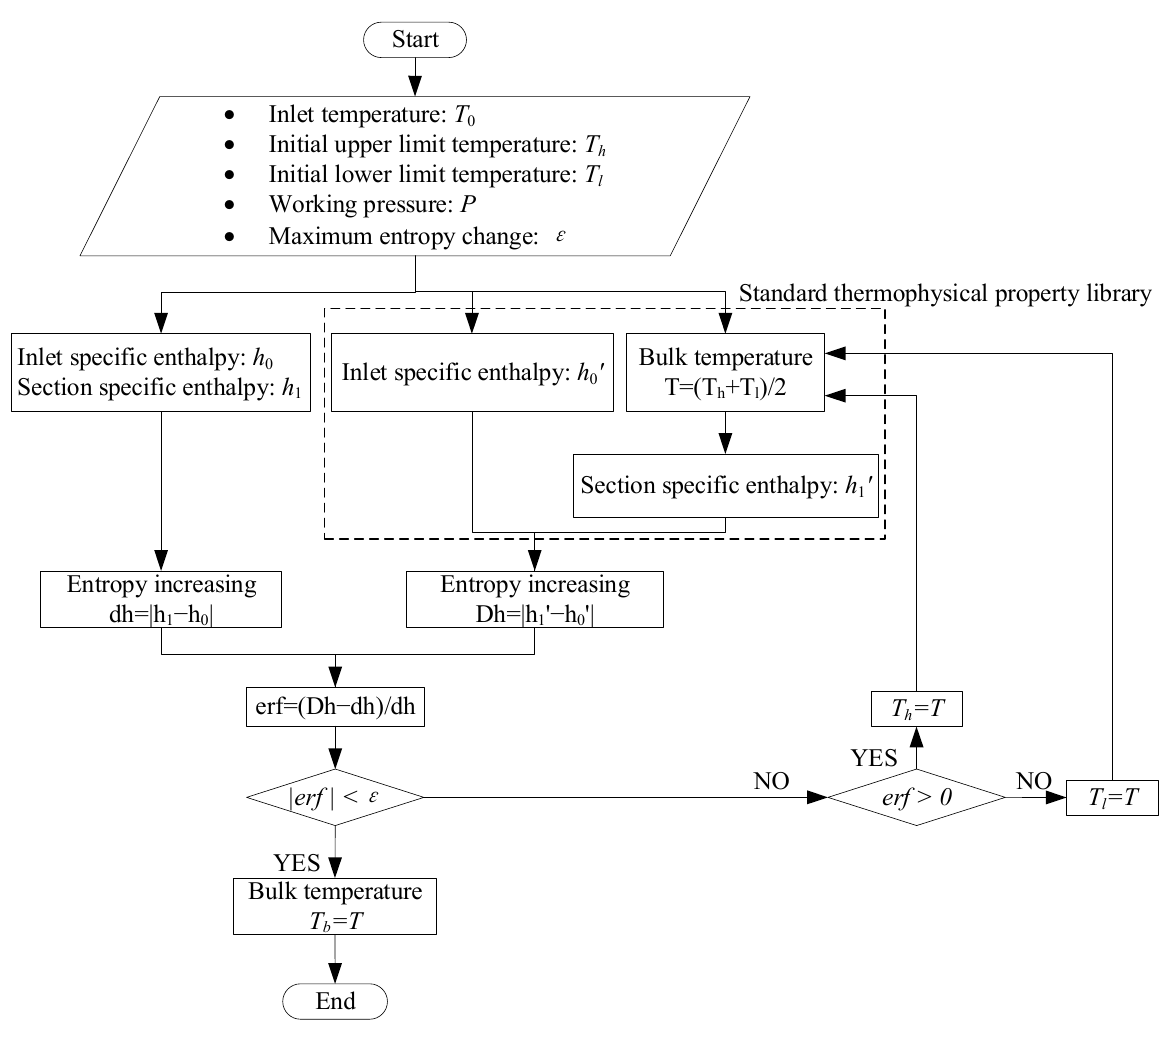
Figure 2. Iteration process for fuel average temperature.